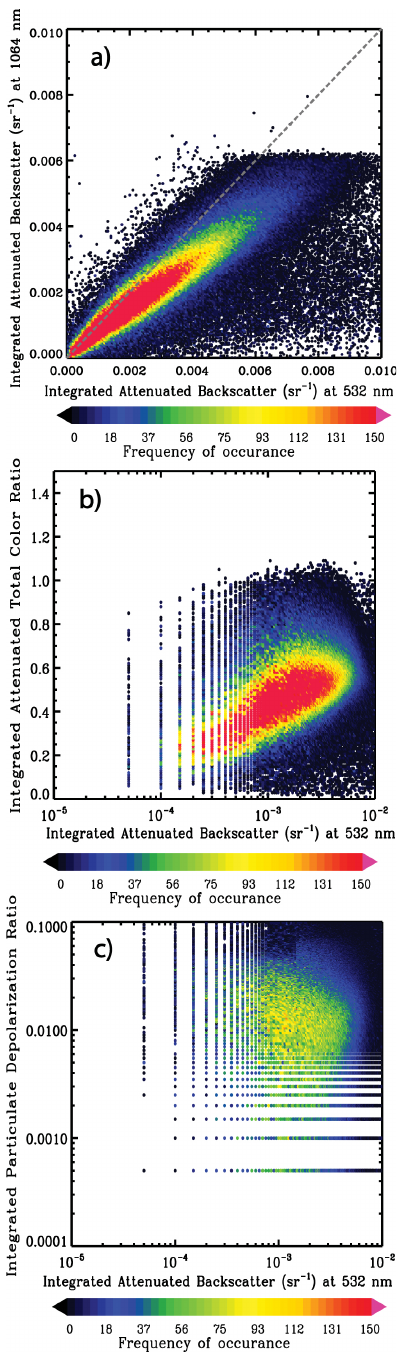
Fig. 4. The CALIPSO lidar relationships for (a) β 1064 – β 532 (b) χ – β 532 and (c) δ p – β 532 for 15 selected regions over the time period of June 2006 to April 2011. The color of each pixel represents the frequency of occurrence and the dashed line on Fig. 4a indicates 1:1